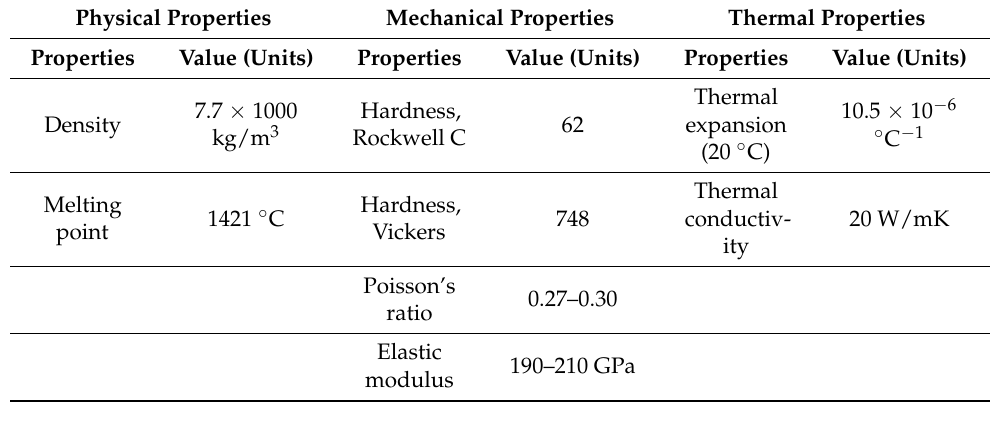
Table 2. Physical, mechanical, and thermal properties of D2-grade tool steel [36].